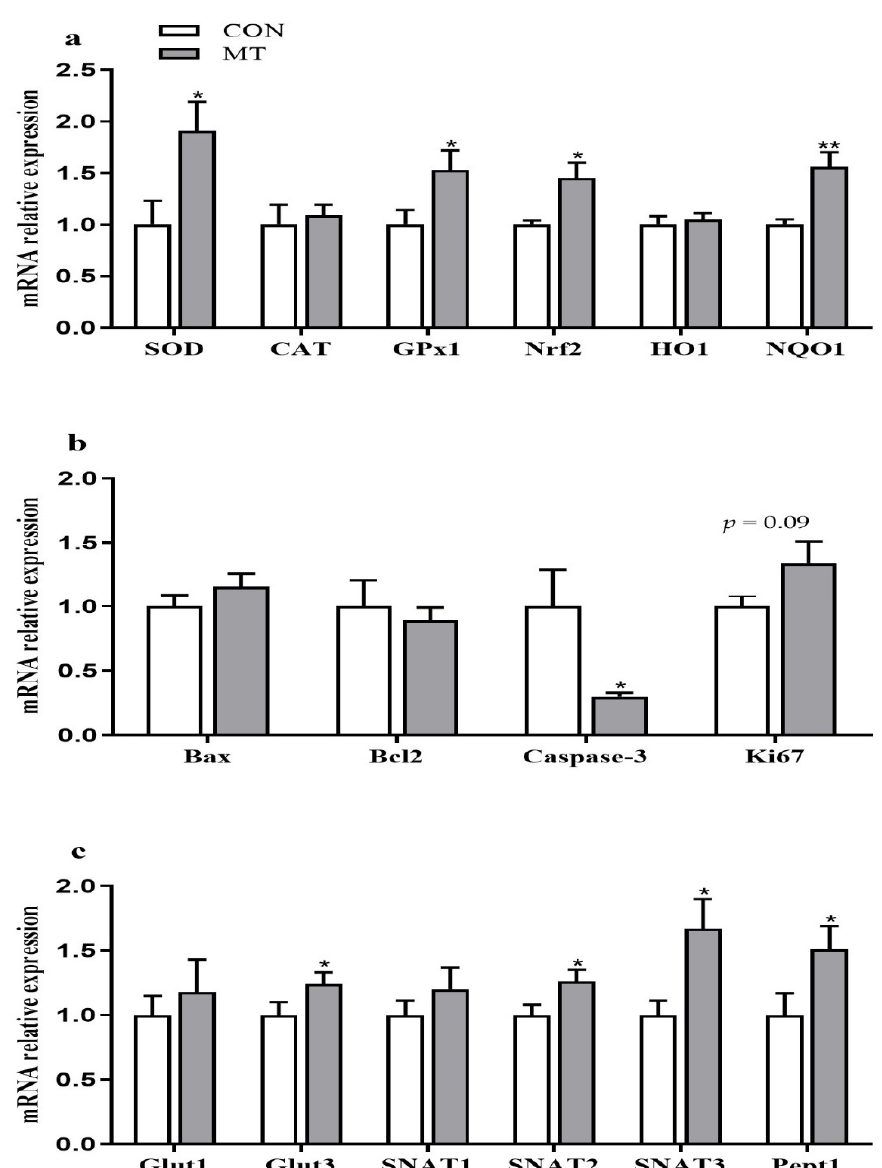
Figure 8. Effects of maternal MT supplementation during gestation on the relative expression levels of critical genes involved in the placental functions. ( a ) Nrf2-regulated gene expression. ( b ) Apoptosis and proliferation-related gene expression. ( c ) Nutrient transporter gene expression. Data are presented as means ± SEM, n = 8. * p < 0.05, ** p < 0.01. CON = control, MT = melatonin, Glut1 = Slc2a1, Glut3 = Slc2a3, SNAT1 = Slc38a1, SNAT2 = Slc38a2, SNAT3 = Slc38a4.